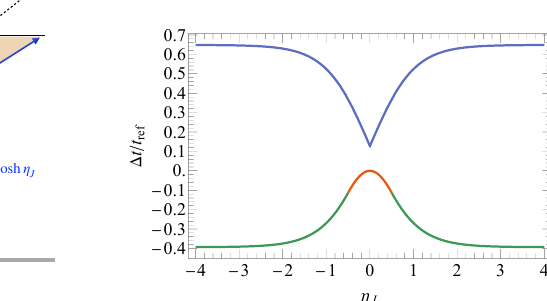
Figure 1 . Illustration of the bounds for a prompt jet (left). The slowest particle time, eq. (3.7), follows the high | η | boundary of the jet (blue). The fastest particle time, eq. (3.8), follows the low | η | boundary of the jet (green) or the η = 0 line (red). Plot of the boundaries for the relative time difference for a jet with R = 0 . 5 (right) where the colored lines correspond to the boundaries in jet the left